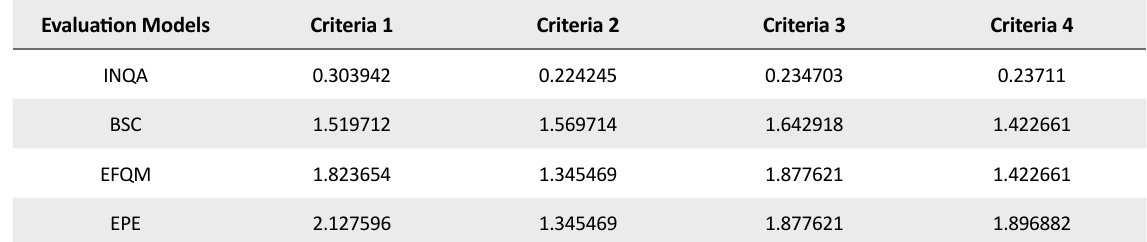
Table 4. The normal score of criteria for each evaluation model based on the weight obtained from AHP Evaluation Models Criteria 1